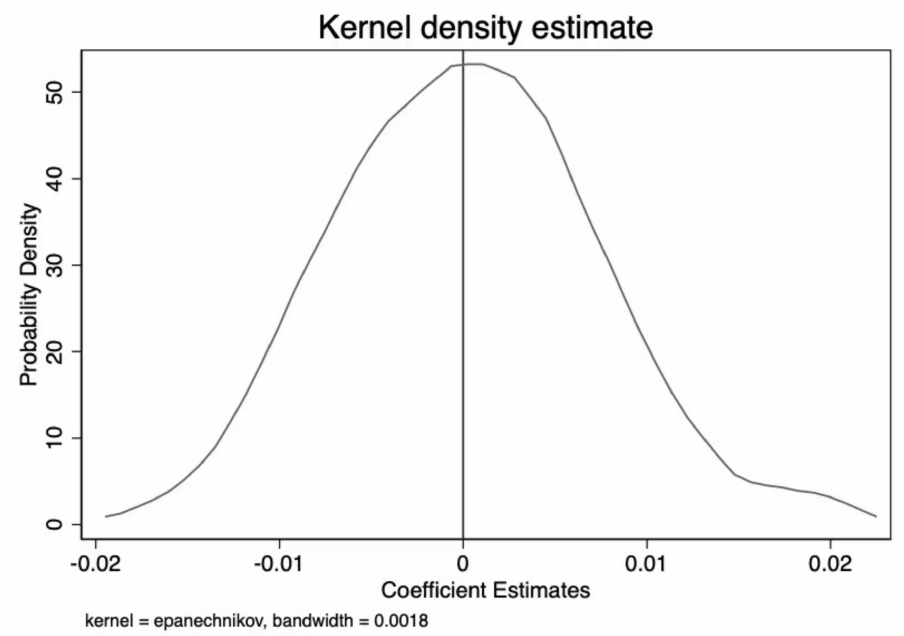
Figure 3. Results of the distribution of the DID estimator for the placebo